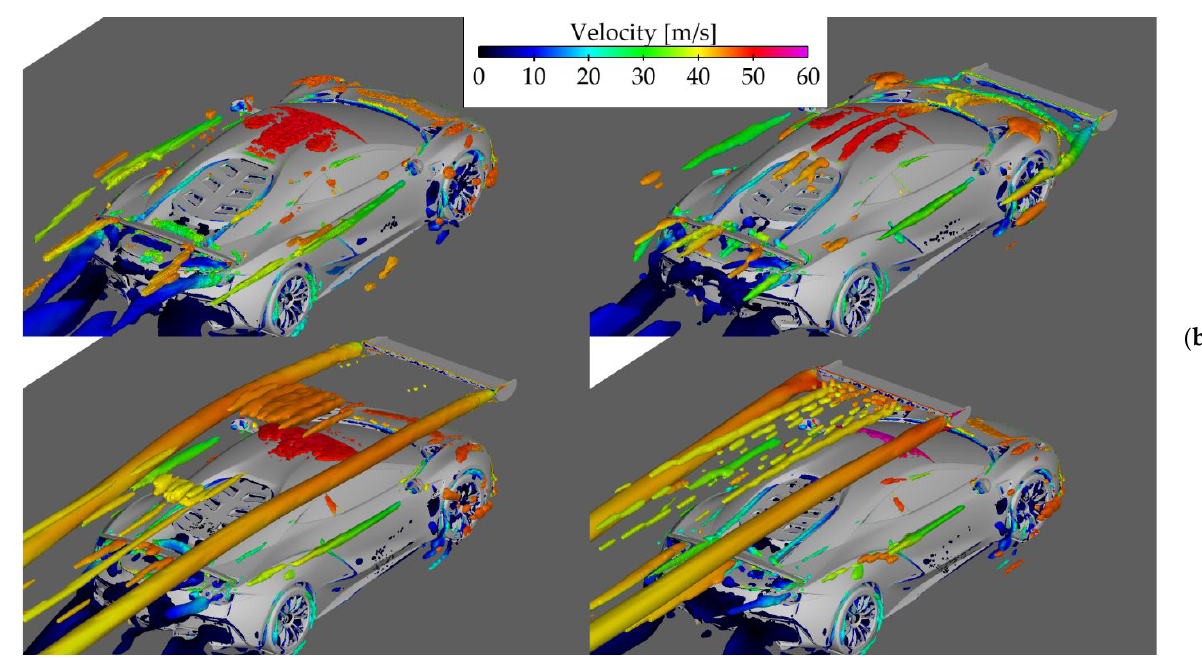
Figure 35. Distributions of the normalized Q = 0.05 parameter around the vehicle without a front wing and for the vehicle with three different wing positions, influenced by velocity magnitude: ( a ) front view; ( b ) rear view. Visualizations are mirrored along the symmetry plane.